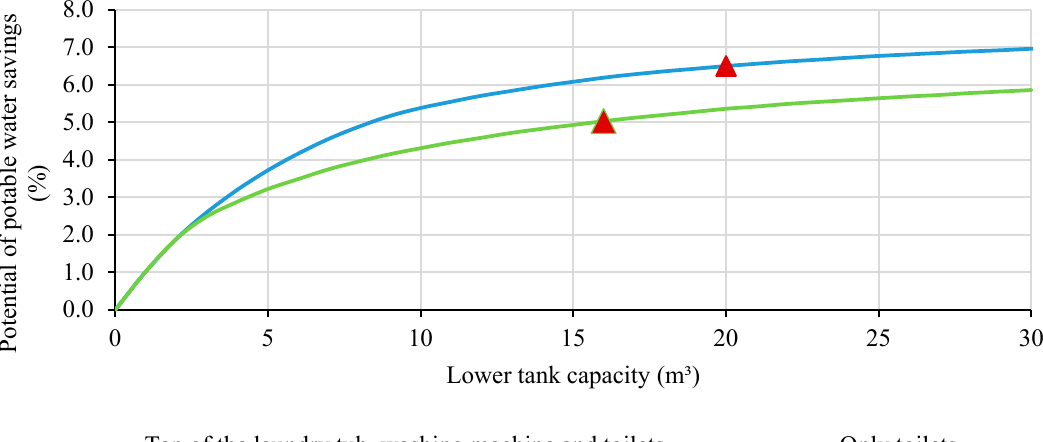
Figure 9. Water tank capacities versus the potential of potable water savings according to simulated scenarios.